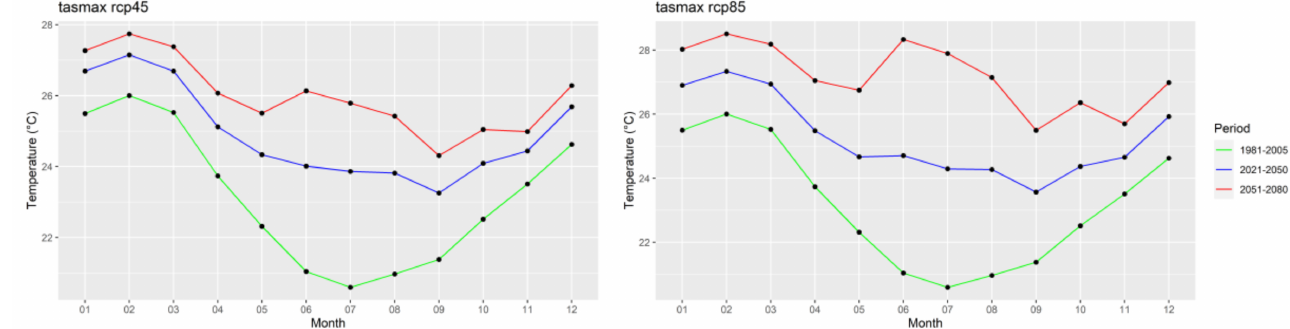
Figure 25. Average monthly temperature (maximum) under RCP4.5 and RCP8.5 scenarios for the Devil’s Creek, 2021–2050 and 2051–2080 periods. The multi-model ensemble average of 15